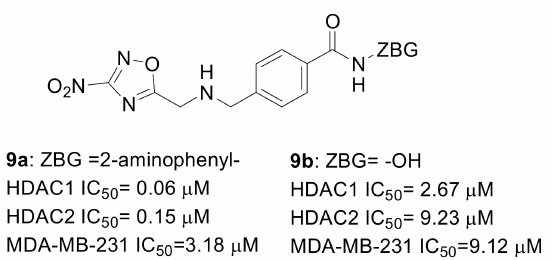
Figure 9. Chemical structure and HDAC inhibition potency of compounds 9a and 9b as anti-TNBC